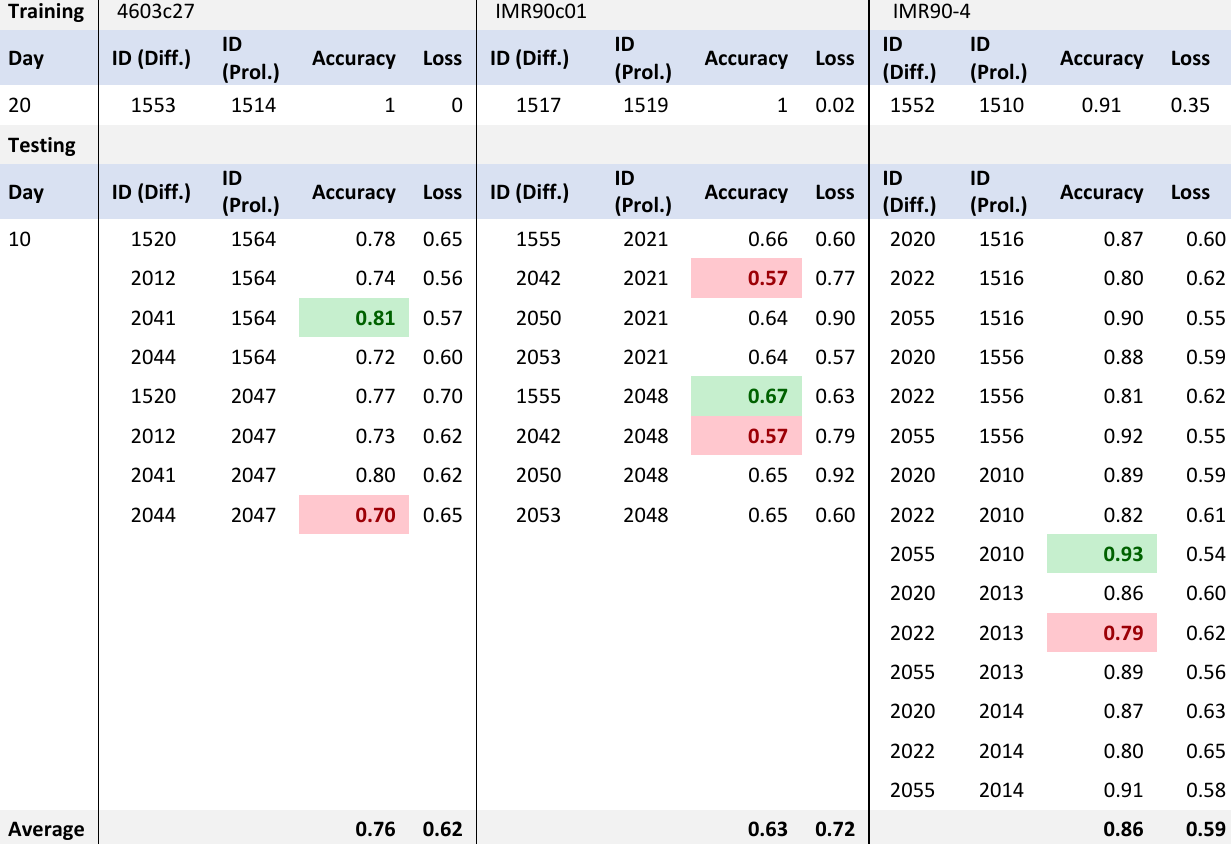
Table 2: Accuracy and loss data for both training and testing (day10) for day 20 cell models. Maximum (green) and minimum (red) values signalled for each cell